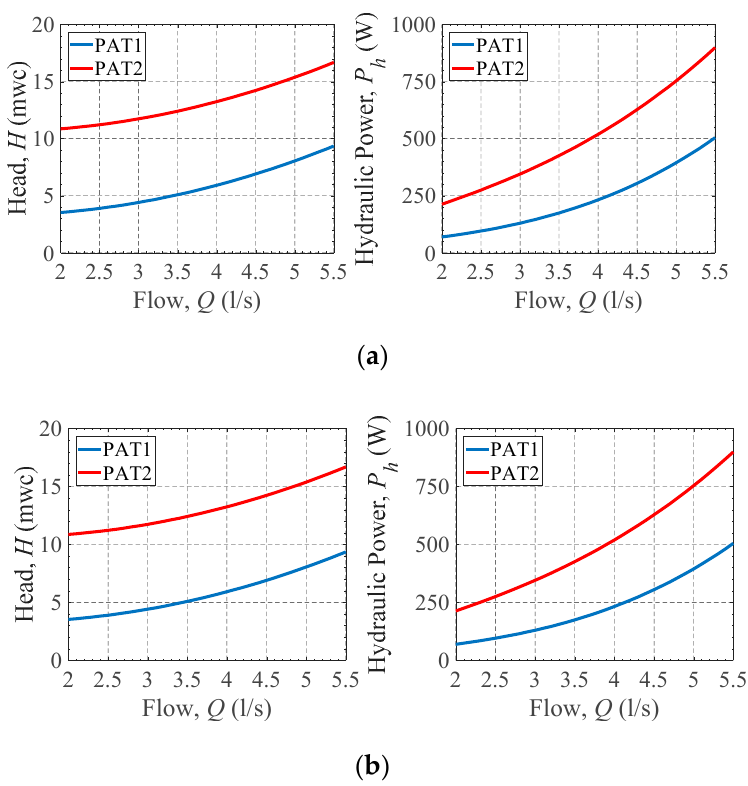
Figure 17. Hydraulic characteristic curves of the original PAT (PAT1, blue color) and the new one (PAT2, red color), for N = N ref : ( a ) head curve and ( b ) hydraulic power curve.